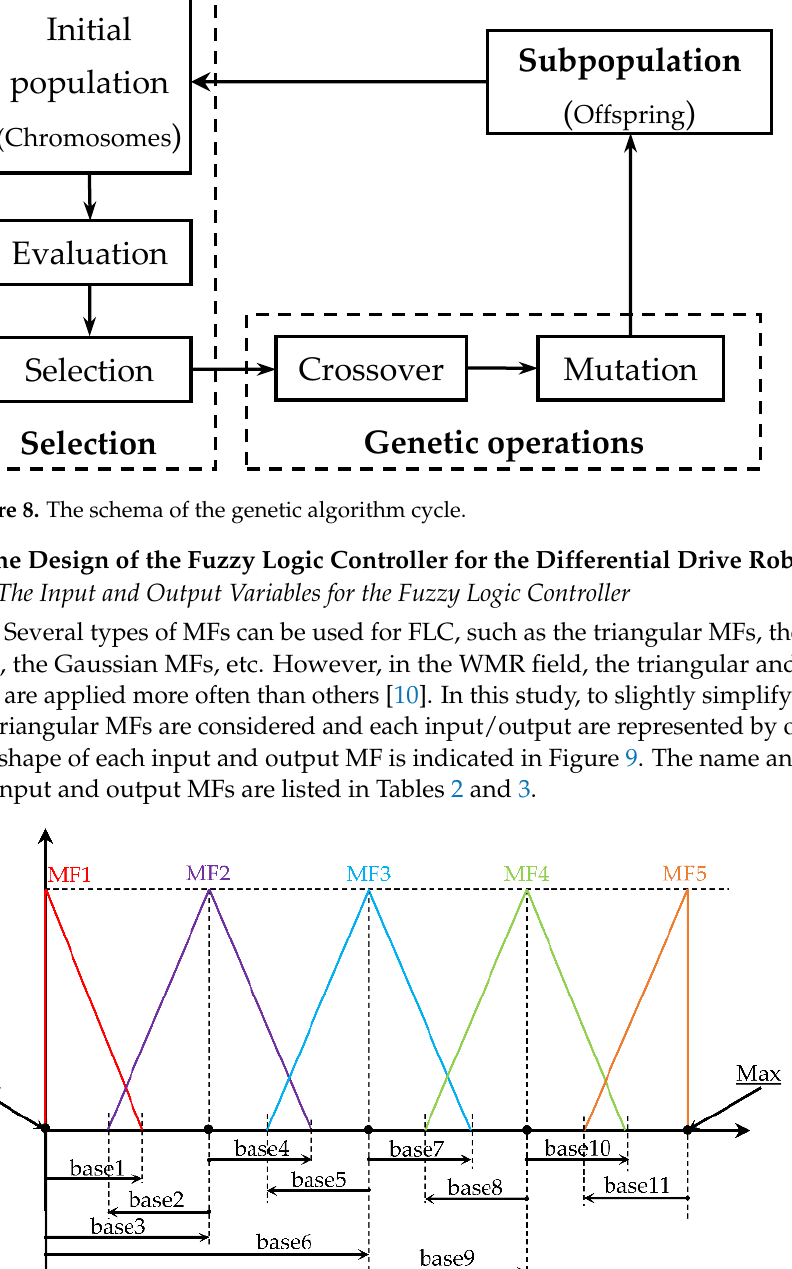
Figure 9. Representation of membership functions of each input and output. Table 2. The input membership functions.